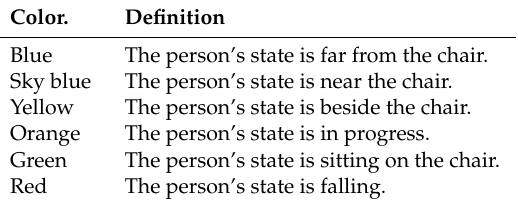
Table 2. List of colors and